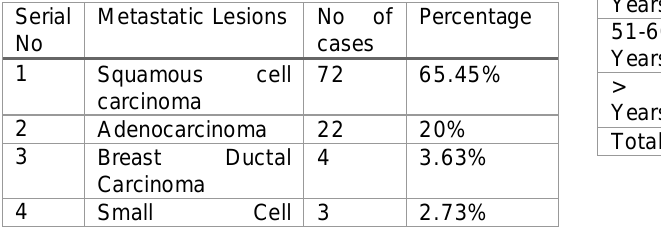
Table No:1 Distribution of different types of Metastatic Lesions.